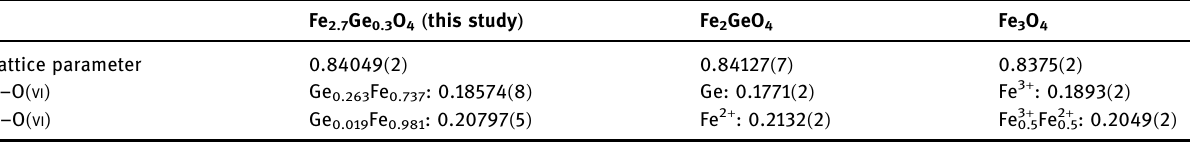
Table 3: Lattice parameter ( nm ) and interatomic distances ( nm ) of Fe 2.7 Ge 0.3 O 4 , Fe 2 GeO 4 ( brunogeierite ) [ 20 ] , and Fe 3 O 4 ( magnetite ) [ 19 ]